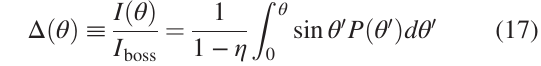
FIG. 5. Same as Fig. 4 but for d Δ =d θ